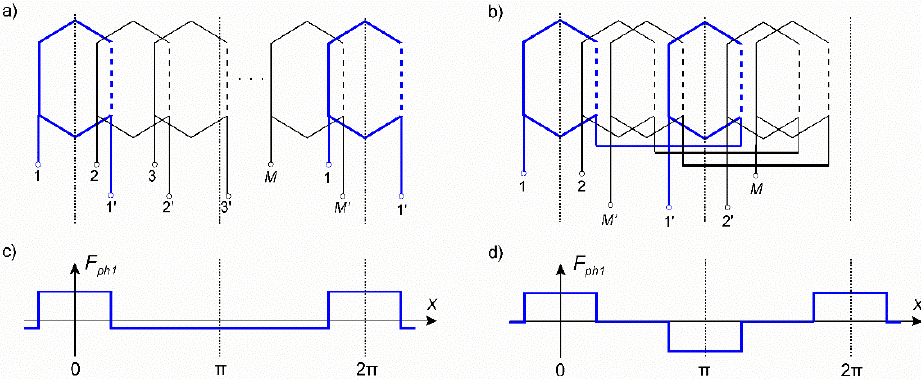
Figure 3. Illustration of two types of multiphase windings composed of single coils: ( a ) structure of the first winding type ( S = 1) where phases are single coils; ( b ) structure of the second winding type ( S = 2) composed of single coils; ( c ) F ph 1 — magnetomotive force (MMF) distribution of the first phase corresponding to the first winding type, ( d ) F ph 1 — MMF distribution of the first phase corresponding to the second winding type ( x — machine angle along the air-gap).